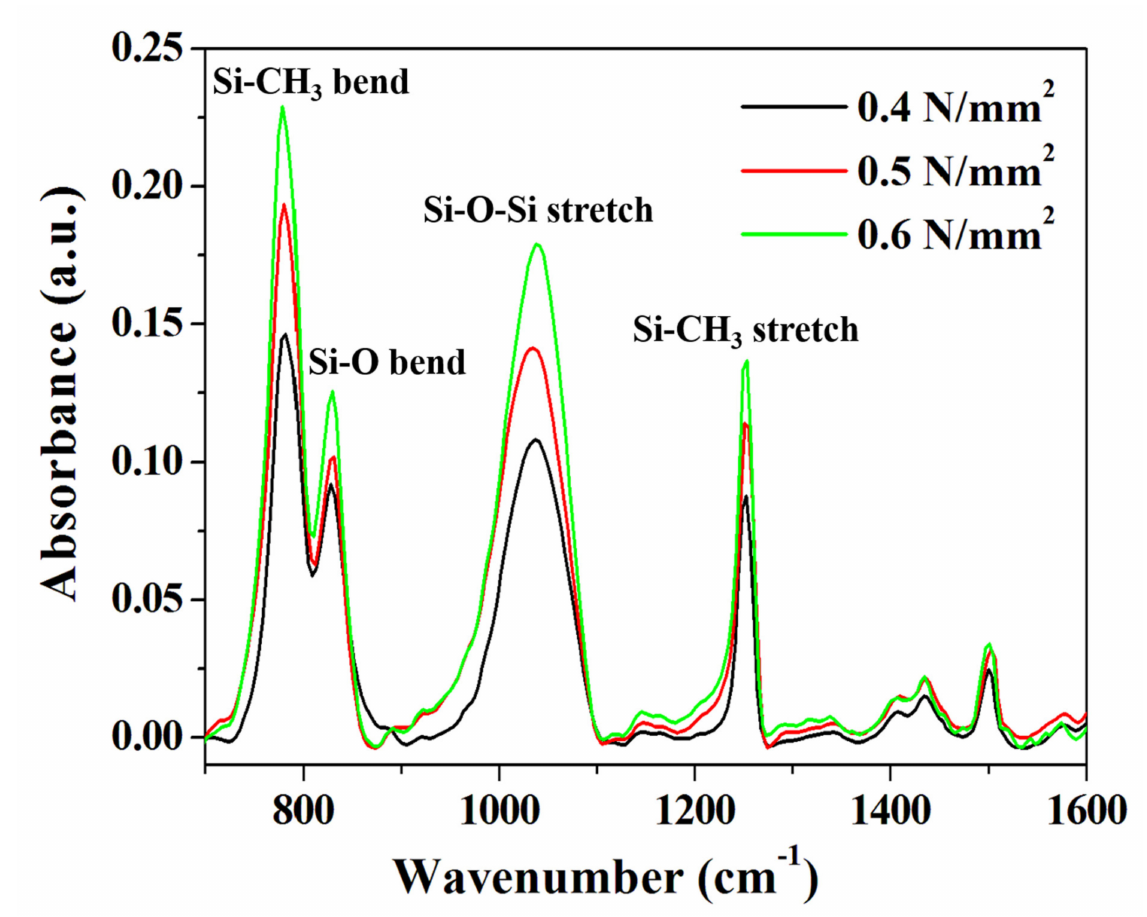
Figure 6. FT-IR absorbance spectra of the DVS-BCB bonding fabricated under various compressive pressure